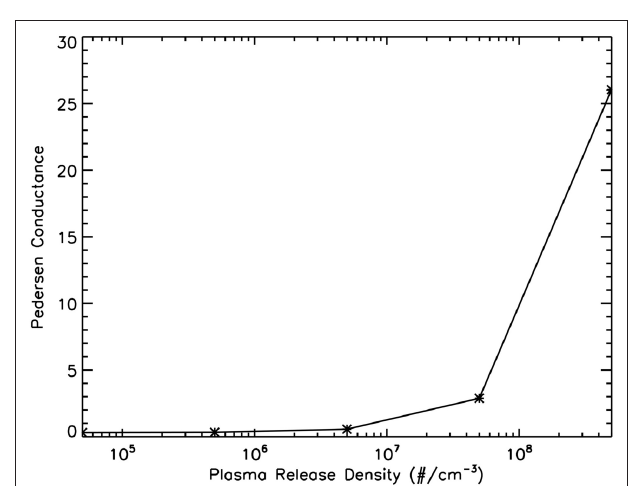
FIGURE 8 | The Pedersen conductance as a function of injected plasma (Al + ) density.